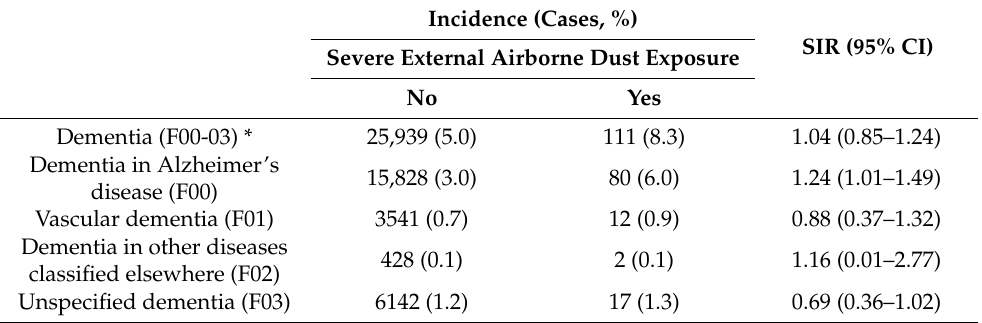
Table 2. Age-standardized incidence ratio and 95% confidence intervals of dementia by severe external airborne dust exposure.